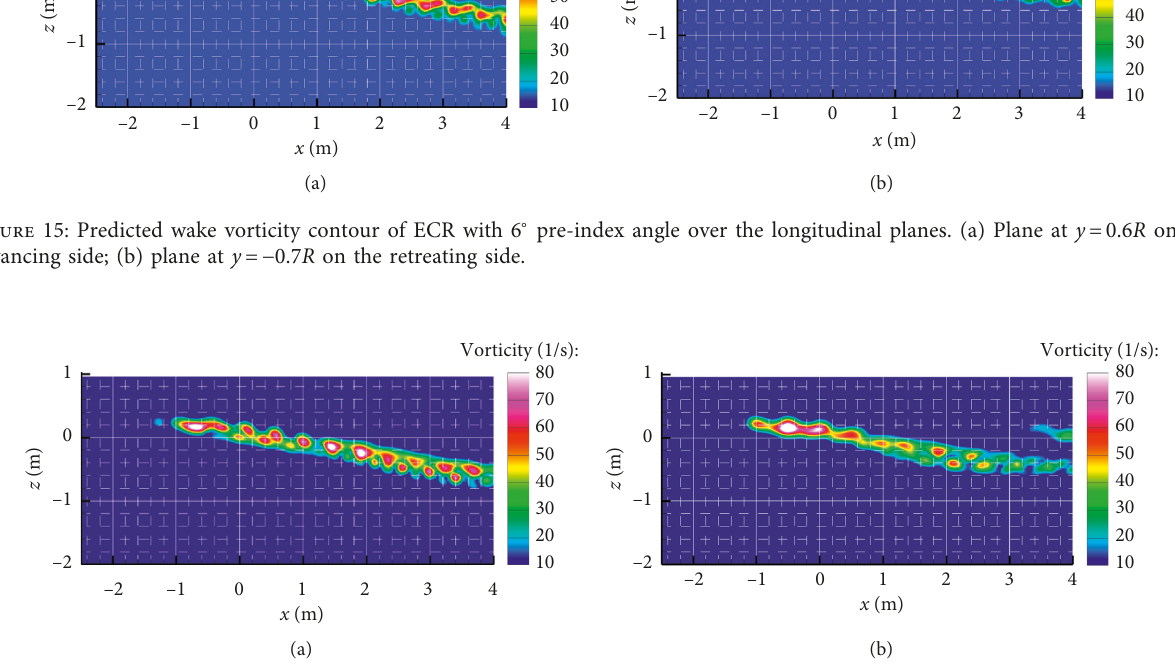
Figure 16: Predicted wake vorticity contour of ECR with 8 ∘ pre-index angle over the longitudinal planes. (a) Plane at y � 0.6 R on the advancing side; (b) plane at y � − 0.7 R on the retreating